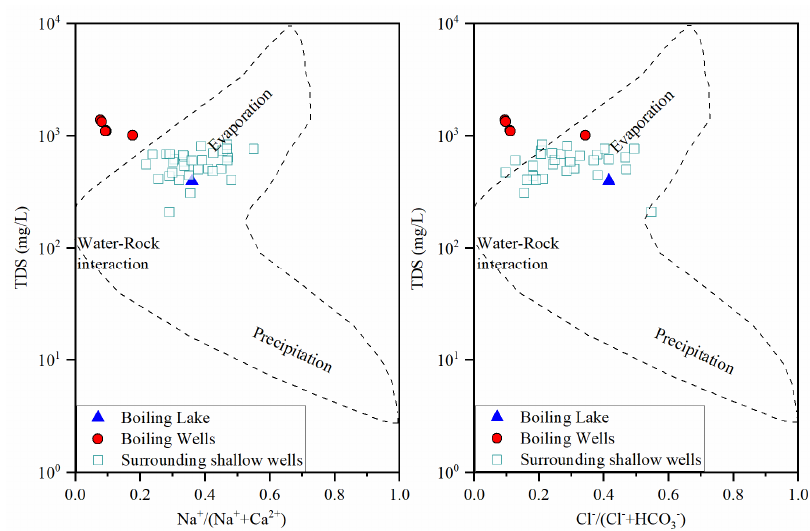
Figure 3. Gibbs figures of the samples in the study area.